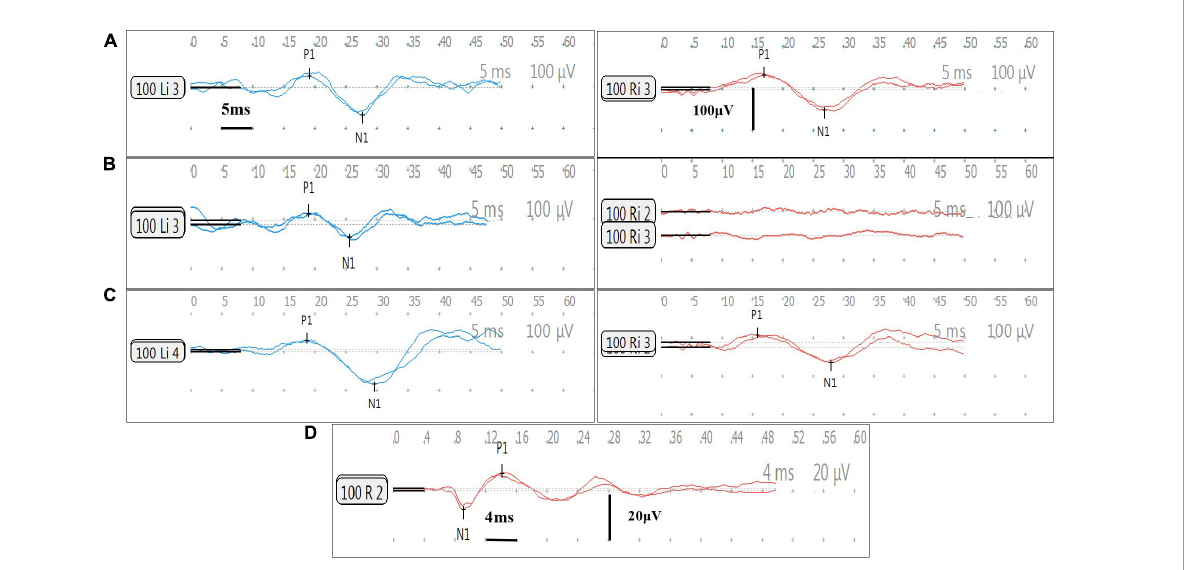
FIGURE1 Cervical vestibular-evoked myogenic potential (cVEMP) and oVEMP responses of Subject 9. All results are obtained in Subject 9. Her right side is implanted. The left side is blue and the right side is red. The cVEMP response (positive P1 first) and oVEMP response (negative N1 first) are recorded at 100 dB HL (500 Hz tone burst). In cVEMP, the horizontal and vertical calibrations are 5 ms and 100 µ V between two adjacent row of points, respectively. In oVEMP, the horizontal and vertical calibrations are 4 ms and 20 µ V, respectively. The two traces show the responses of the repeat stimulus. The amplitude ratio (AR) is defined as the difference between the amplitudes of two sides divided by the sum of the amplitudes of two sides. (A) Normal bilateral cVEMP responses before surgery. The amplitude is 92.9 µ V on the left side and is 82.8 µ V on the right, with a AR of 5.7%. (B) Normal left cVEMP response and absent right cVEMP response at 1 month after surgery. The amplitude is 60.5 µ V on the left and the AR is 100%. (C) Normal bilateral cVEMP responses at 12 months post-surgery. The amplitude is 113.2 µ V on the left and is 71.9 µ V on the right, with a AR of 22.3%. (D) Normal right oVEMP response at 12 months post-surgery. The amplitude is 14.6 µ